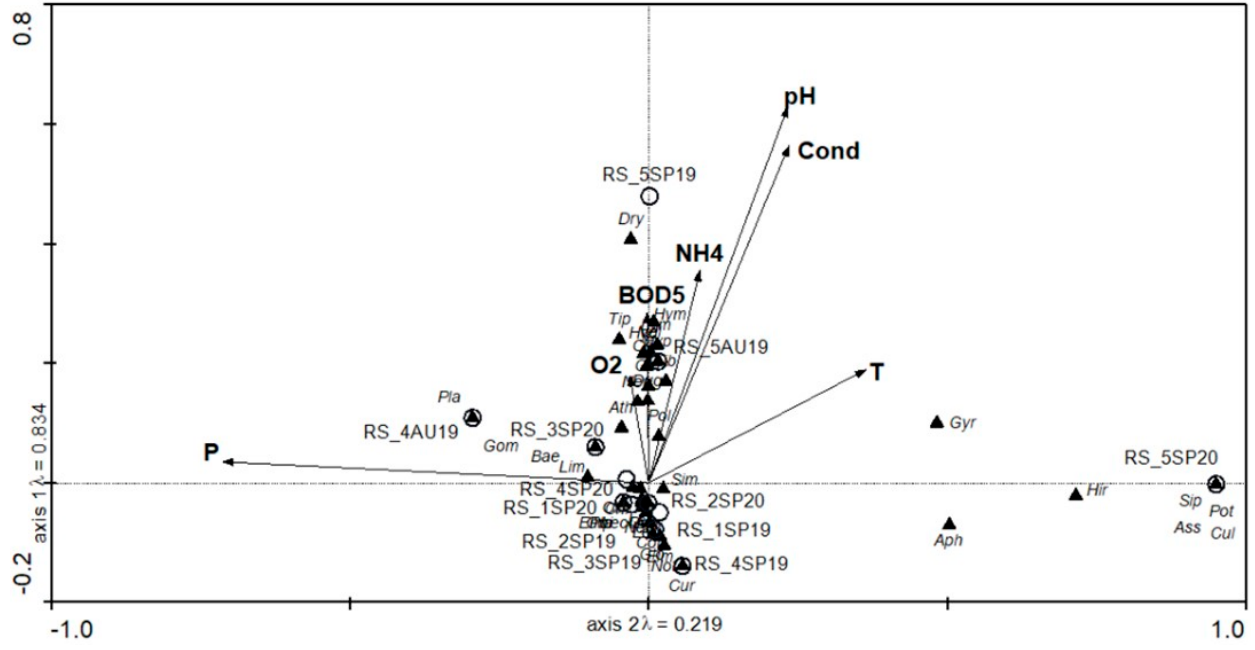
Figure 3. CCA biplot of sampling sites ( О ), environmental variables ( → ), and macroinvertebrates ( ) analyses. The variables are represented by arrows (T-temperature; pH; Cond-conductivity; O 2 - oxygenation; NH 4 -ammoniacal nitrogen; P-total phosphorus). The sampling site codes correspond to each of the five points (Figure 1) in each data collection, and taxa abbreviations are presented in